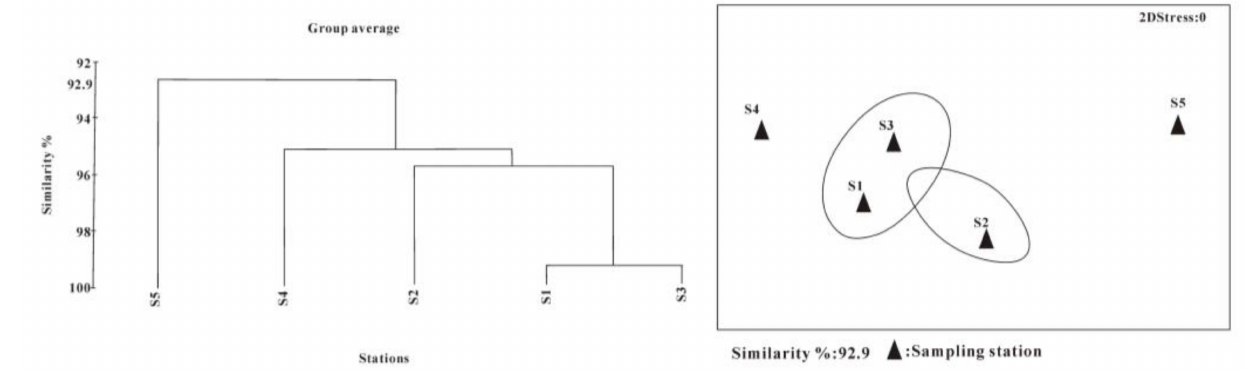
Figure 8. Cluster and n-MDS plots based on abundance of taxa, density, and diversity in each